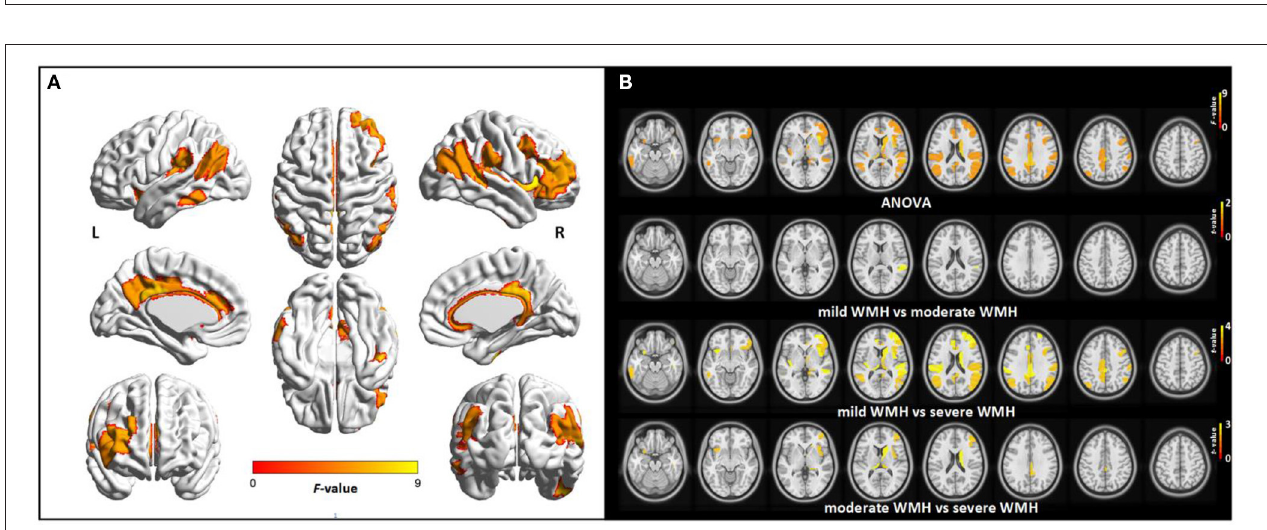
FIGURE 1 | Spatial distribution maps CBF and FCS in subjects with different WMH grades. CBF and FCS maps are normalized to z -values and averaged among subjects within each group. CBF, cerebral blood flow; FCS, functional connectivity strength; WMH, white matter hyperintensities.